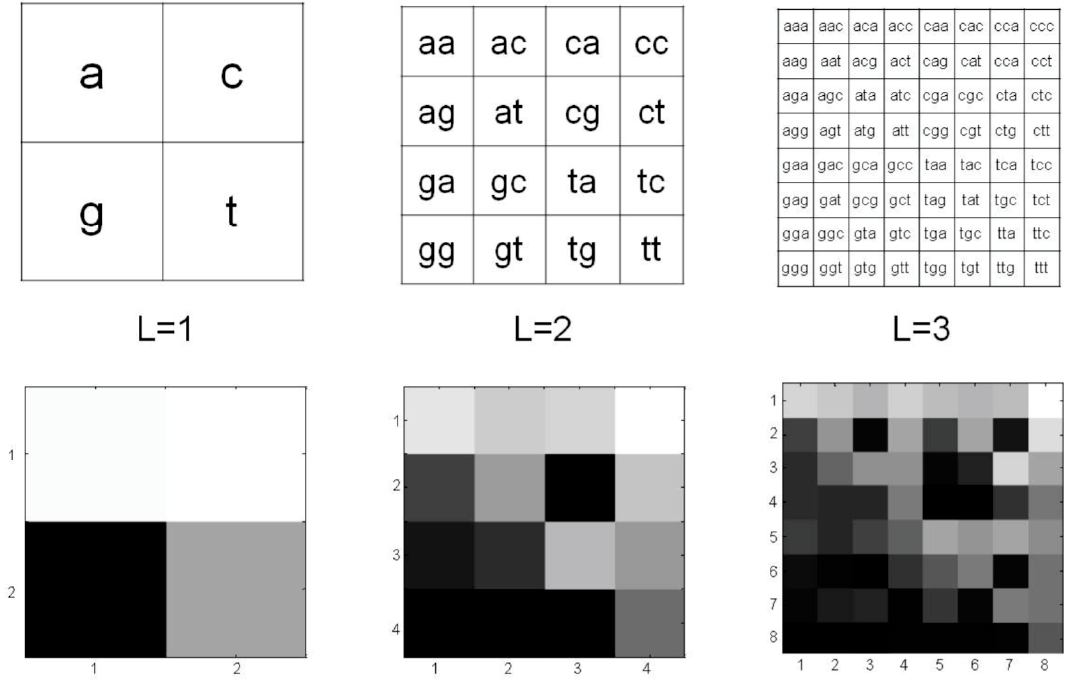
Figure 1. Rendering of Chaos Game Representation method. ( Top ) CGR display in 2 L × 2 L matrices for L = 1, 2, 3 in the case of DNA four-symbol alphabet {a, c, g, t}. ( Bottom ) CGR images of rCRS, revised Cambridge Reference Sequence, for the same matrix sizes.